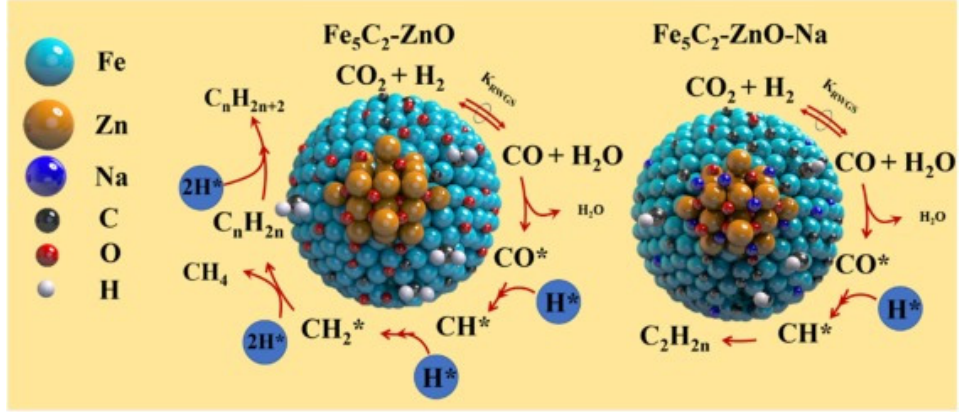
Figure 2. Reaction mechanism of CO 2 hydrogenation over Na-free and Na-doped Fe 5 C 2 –ZnO catalysts. Reproduced from Ref. [32] with copyright license from Elsevier (2021).